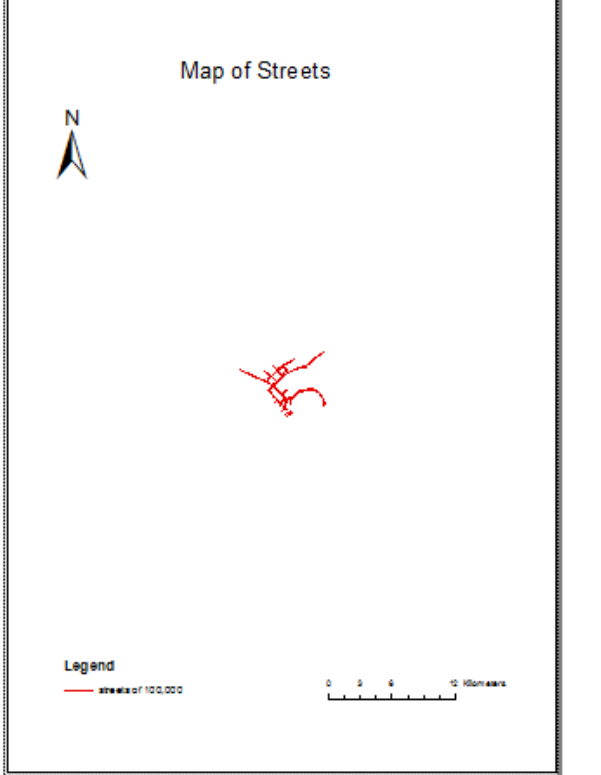
Fig.17: The network of roads map from (map at 1:100,000) producing with 1:250,000